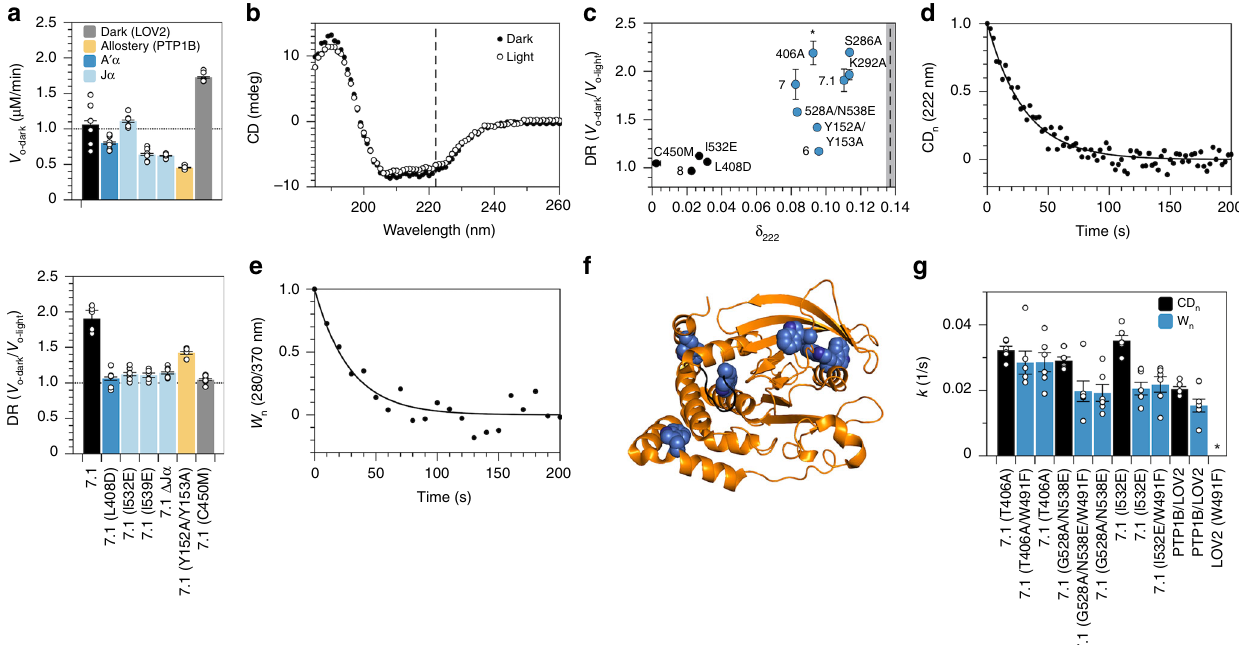
Fig. 2 Analysis of allosteric communication in PTP1B PS . a Mutations that either prevent adduct formation in LOV2 (C450M), destabilize the A ’ α and J α helices (I532E, I539E, and Δ J α ), or disrupt the allosteric network of PTP1B (Y152A/Y153A) reduce the photosensitivity of 7.1 and, with the exception of I532E and C450M, lower its speci fi c activity. The plotted data depict the mean, SE, and associated estimates of DR for n = 6 independent experiments. b Exposure of PTP1B PS to 455nm light reduces its α -helical content (i.e., the mean residue ellipticity [MRE] at 222nm). c An analysis of different chimeras indicates that light-induced changes in α -helical content (i.e., δ 222 = [CD 222-dark − CD 222-light ]/CD 222-dark , or the fractional change in MRE at 222nm) are necessary, but not suf fi cient for light-sensitive catalytic activity (i.e., high DR). Mutations correspond to variants of 7.1. Chimeras with large values of δ 222 appear in blue; the dashed line indicates δ 222 for equimolar amounts of free PTP1B and LOV2. Error bars denote SE for n = 6 independent reactions. d , e Thermal recovery of ( d ) α -helical content (i.e., the change in MRE at 222nm normalized by the full change over 250s) and ( e ) tryptophan fl uorescence (i.e., the change in fl uorescence normalized by the full change over 250s) of PTP1B PS . f A crystal structure of PTP1B (pdb entry 2f71) shows the locations of six tryptophan residues (blue) and the WPD loop (black). g Kinetic constants for thermal recovery are larger for α -helical content than for tryptophan fl uorescence (the latter of which is not affected by W491; *, unmeasurable). The discrepancy between these constants is smallest for PTP1B PS (i.e., 7.1(T406A)). The plotted data depict the mean, associated data points, and SE for n = 6 independent reactions. Source data are provided as a Source Data fi